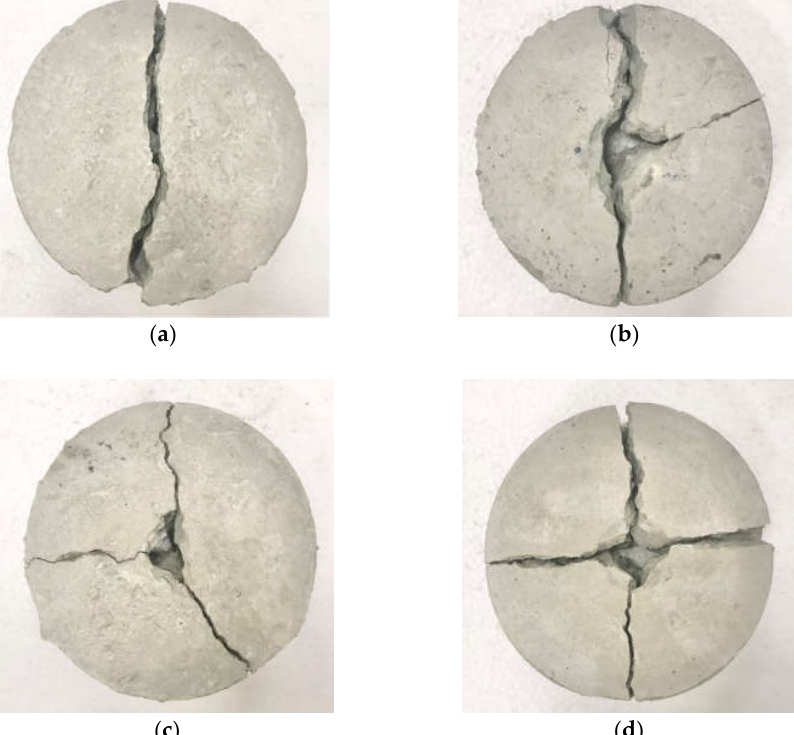
Figure 10. The failure photos of the KFRC specimens under repeated impact at 50 J: ( a ) I-B; ( b ) I-AK10L24; ( c ) I-M5/5; ( d ) I-K10L24.